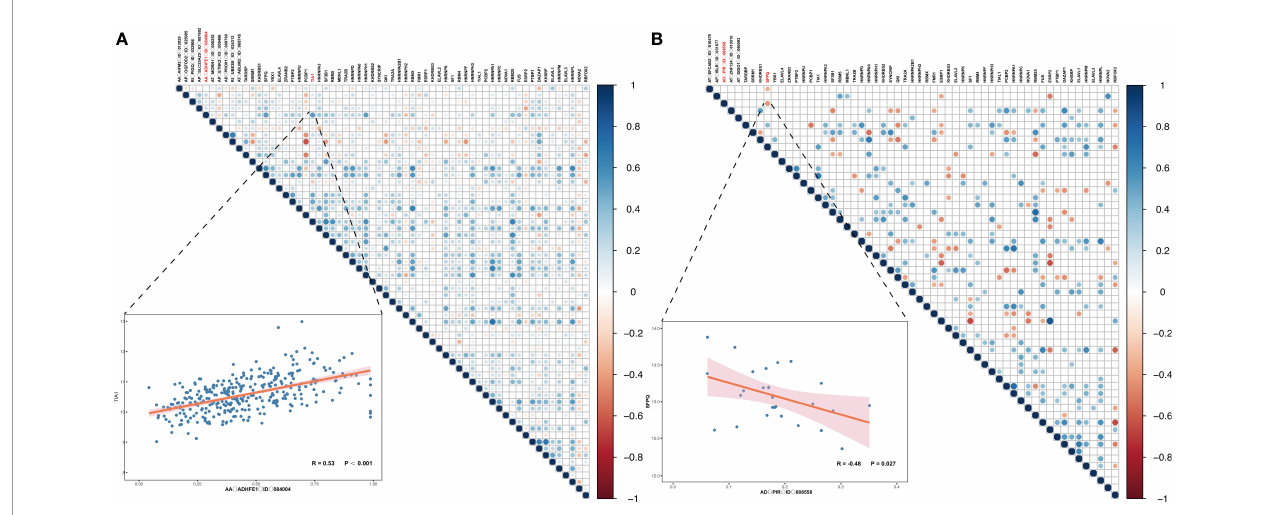
FIGURE 8 | Correlation analyses between SFs and OS-/DFS-DEAS events in HCC and ICC. (A, B) The correlation between SFs and OS- and DFS-DEAS events in HCC (A) and ICC (B) . The right fi gure displays the signi fi cance and the correlation coef fi cient between the expression of SFs and the PSI values of OS-/DFS-DEAS events. If there is a circle, P <0.05, and the size of the circle represents the size of P value. The color of the circle represents the correlation coef fi cient. The left fi gure demonstrates the correlation between the PSI values of representative DEAS events and expression of